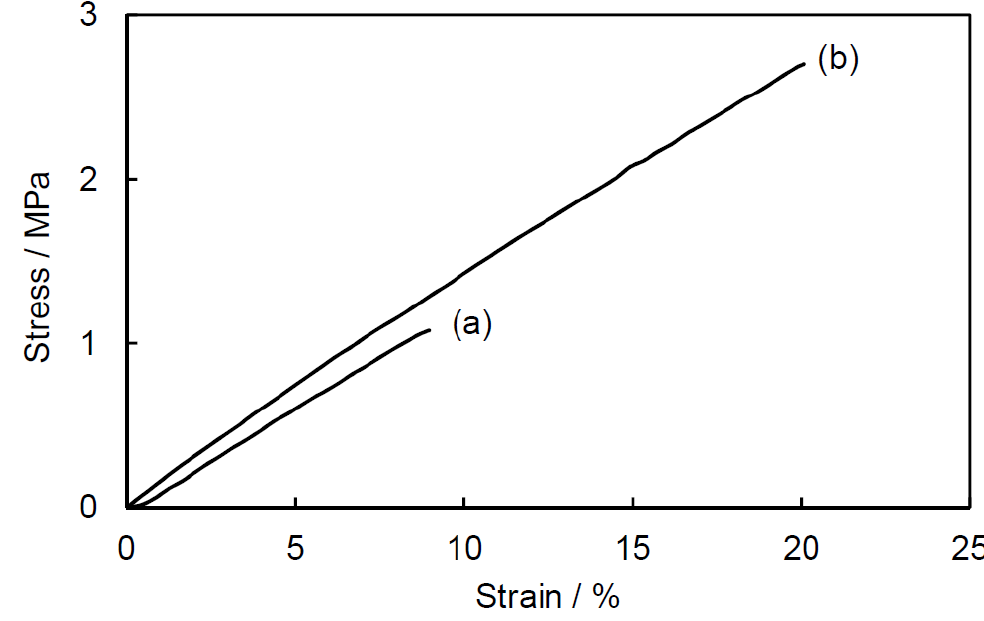
Figure 6. Strain-stress curves of ( a ) ESO homopolymer and ( b ) ESO/POSS-1 nanocomposite (90:10